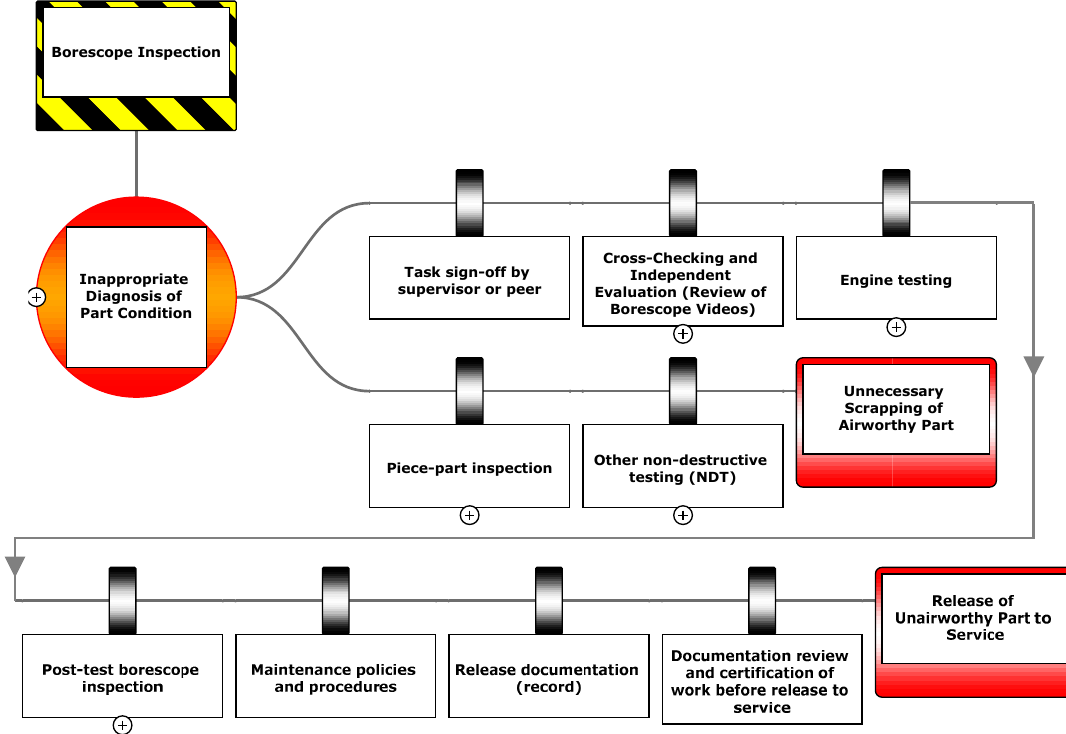
Figure 7. Right half of the Bowtie diagram with consequences and recovery barriers.